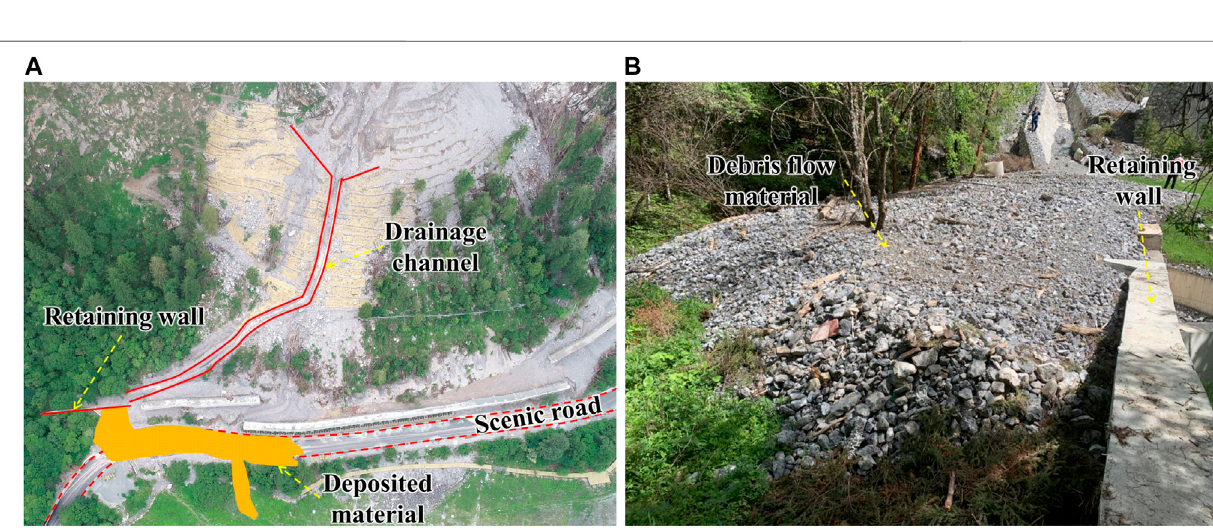
Frontiers in Earth Science |